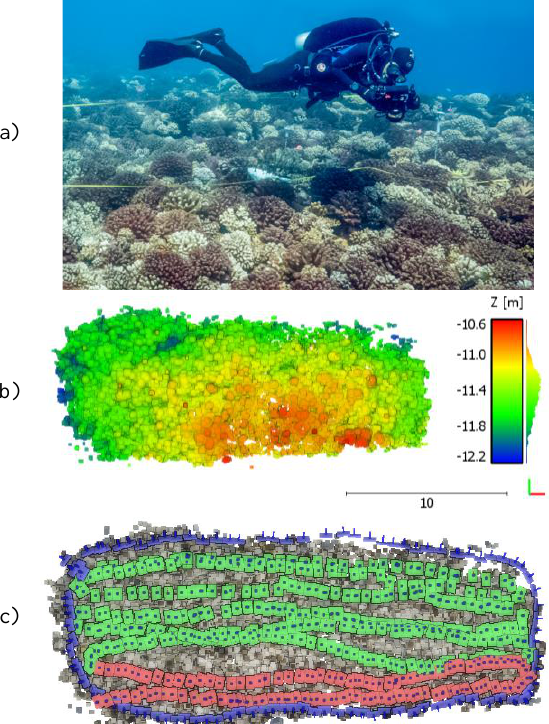
Figure 2. Underwater dataset used for the simulation. SCUBA diver while acquiring the dataset (a); 3D point cloud color coded according to depth (b); camera network (c) with single round trip nadir strip (red), remaining nadir strips (green), oblique images